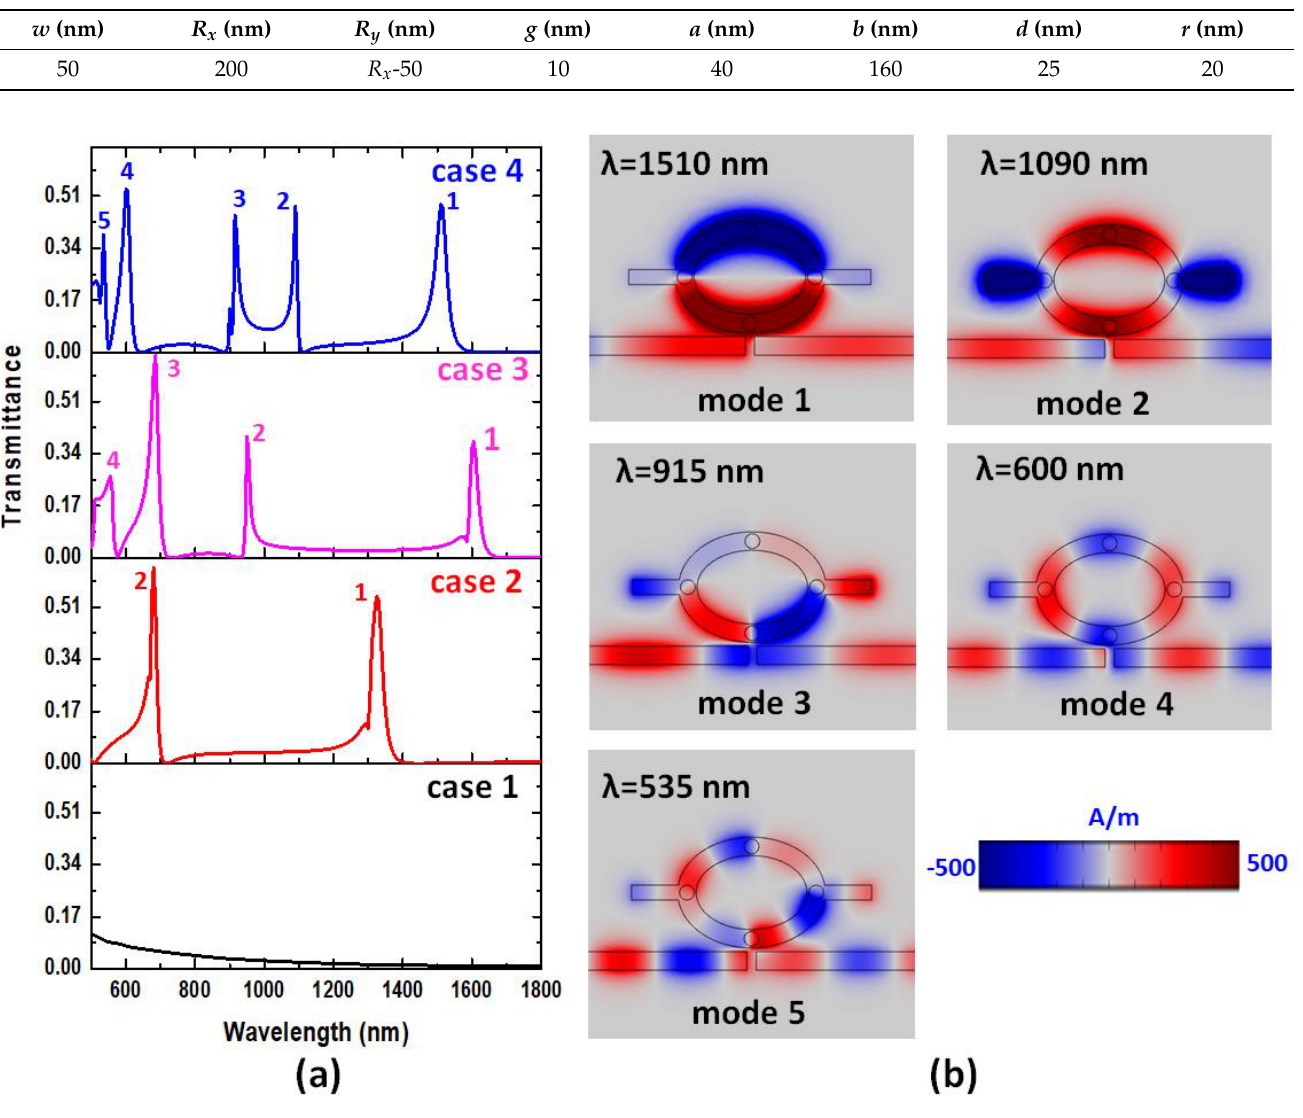
Table 2. Initial geometrical parameters of the proposed plasmonic sensor.